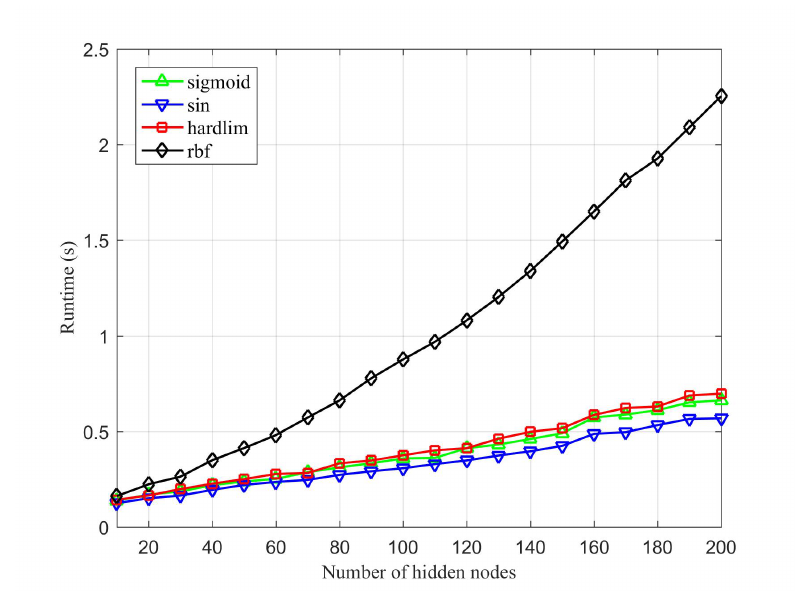
Figure 6. Runtime of ILECA under different activation